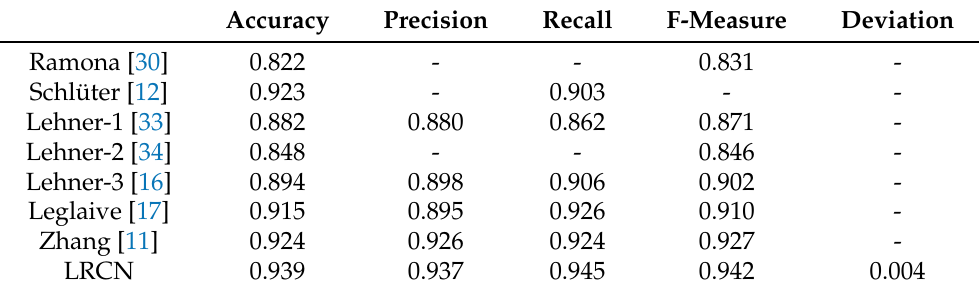
Table 3. Comparison of the SVD system with existing methods on